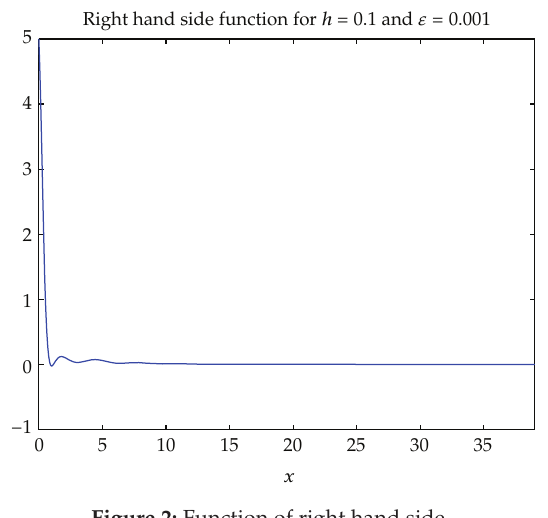
Figure 2: Function of right hand side.